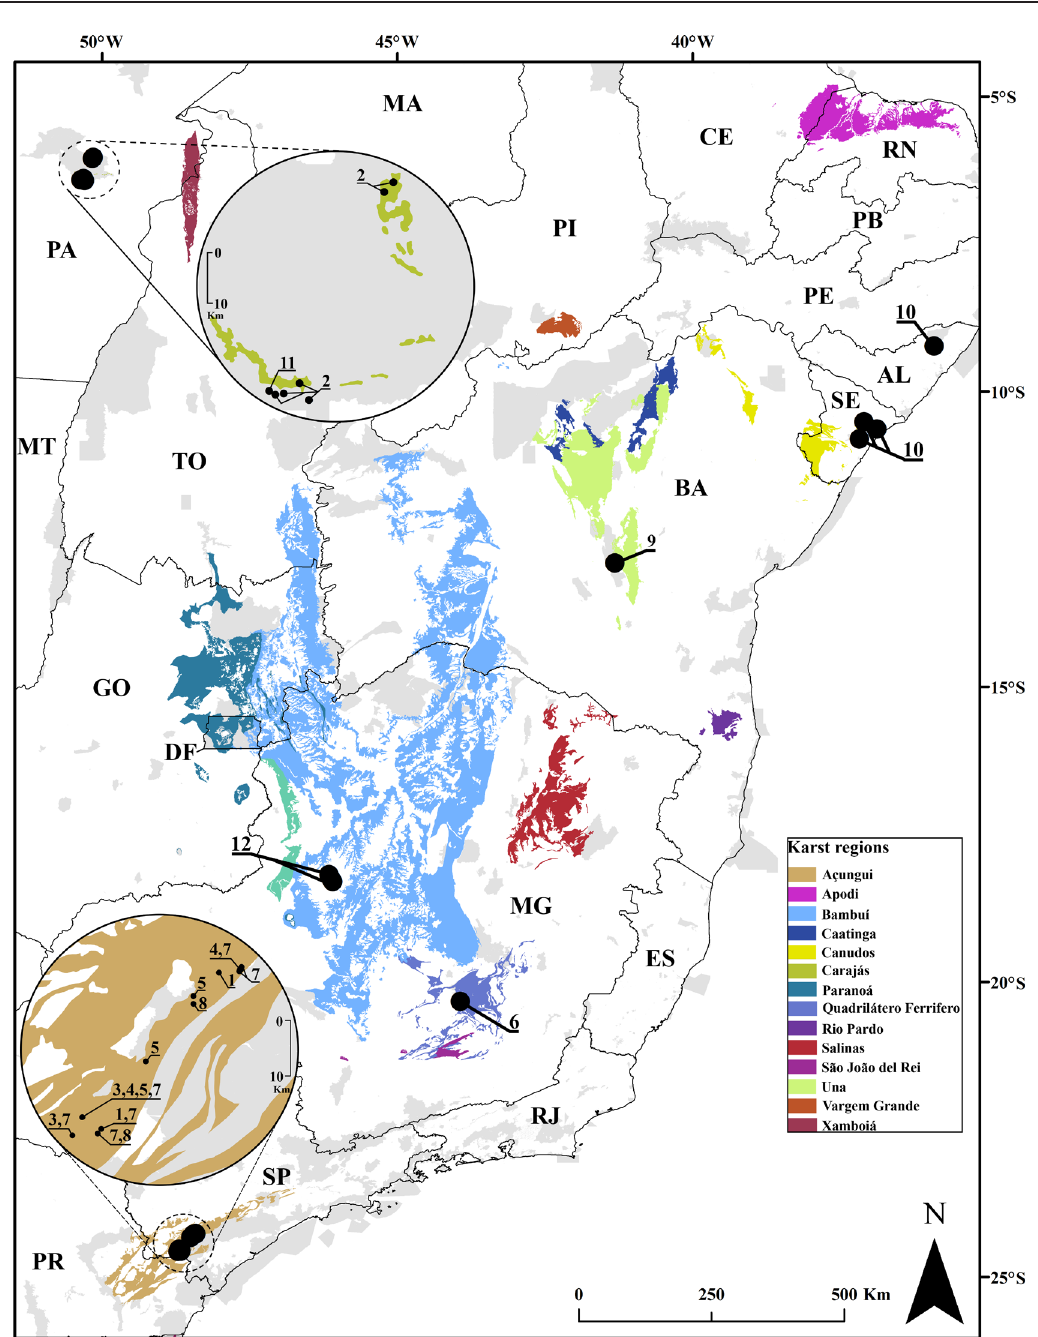
Fig. 14. Distribution map. 1 . Alboscia jotajota Campos-Filho, Bichuette & Taiti sp. nov. 2 . Androdeloscia akuanduba Campos-Filho, Cardoso & Taiti sp nov. 3 . Atlantoscia inflata Campos-Filho & Araujo, 2015. 4 . Benthana iporangensis Lima & Serejo, 1993. 5 . B. longicornis Verhoeff, 1941. 6 . B. olfersii (Brandt, 1833). 7 . B. picta (Brandt, 1833). 8 . B. taeniata Araujo & Buckup, 1994. 9 . Metaprosekia igatuensis Campos-Filho, Fernandes & Bichuette sp. nov. 10 . Paratlantoscia rubromarginata (Araujo & Leistikow, 1999). 11 . Amazoniscus spica Campos-Filho, Aguiar & Taiti sp. nov. 12 . Circoniscus bezzii Arcangeli, 1931. Light gray areas denote Brazilian conservation units. AL = Alagoas; BA = Bahia; CE = Ceará; DF = Distrito Federal; ES = Espírito Santo; GO = Goiás; MA = Maranhão; MG = Minas Gerais; MT = Mato Grosso; PA = Pará; PB = Paraíba; PE = Pernambuco; PI = Piauí; PR = Paraná; RJ = Rio de Janeiro; RN = Rio Grande do Norte; SE = Sergipe; SP = São Paulo; TO =